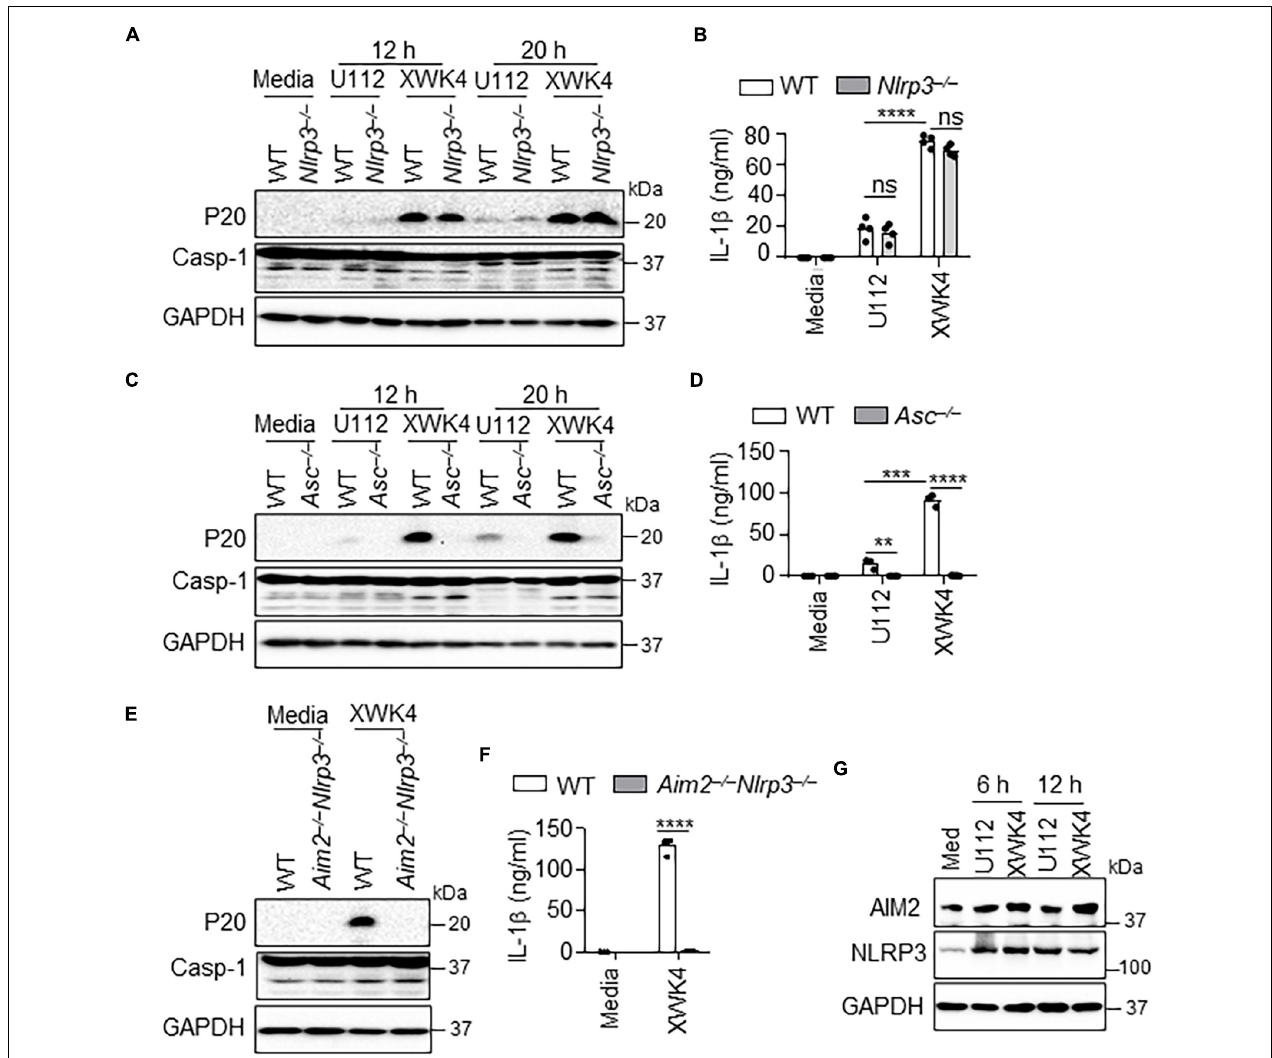
FIGURE 3 | XWK4 triggers both AIM2 and NLRP3 inflammasomes activation. (A) Immunoblot analysis of caspase-1 (cleaved, P20) in WT and Nlrp3 − / − BMDMs with and without infection of U112 and XWK4 (200 MOIs) for indicated times. (B) Analysis of IL-1 β release in WT and Nlrp3 − / − BMDMs with and without infection of U112 and XWK4 (200 MOIs) for 20 h. (C) Immunoblot analysis of caspase-1 (cleaved, P20) in WT and Asc − / − BMDMs with and without infection of U112 and XWK4 (200 MOIs) for indicated times. (D) Analysis of IL-1 β release in WT and Asc − / − BMDMs with and without infection of U112 and XWK4 (200 MOIs) for 20 h. (E,F) Immunoblot analysis of caspase-1 (E) and analysis of IL-1 β release (F) in WT and Aim2 − / − Nlrp3 − / − BMDMs with and without infection of U112 and XWK4 (200 MOIs) for 20 h. (G) Immunoblot analysis of AIM2 and NLRP3 in WT BMDMs with and without infection of U112 and XWK4 (100 MOIs) for indicated times. ** P < 0.01; *** P < 0.001; **** P < 0.0001; ns, not significant (two-sided Student’s t -test without multiple comparisons correction). Data are representative of three independent